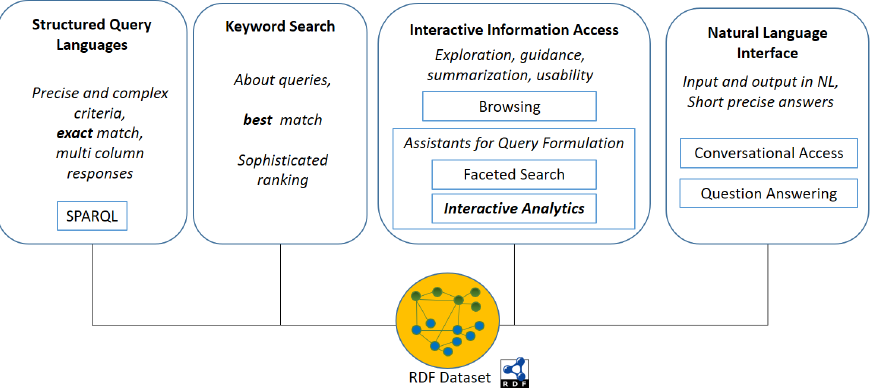
Figure 4. An Overview of the Access Methods over